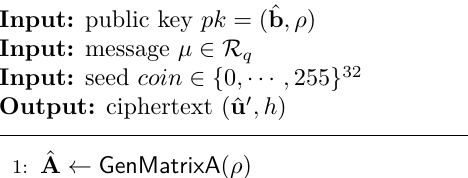
Algorithm 5 Kyber.CPAPKE